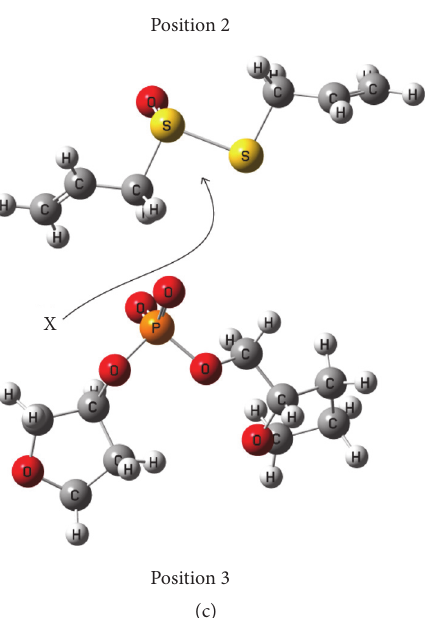
Figure 2: Investigated complex structures: allicin cases with G-C base pair (a), A-T base pair (b), and bridge of base pairs (c) after optimizations. X shows the initial position before optimization. Positions 1, 2, and 3 represent the pattern of artificial made initial model structures and its complexes. Similar complexes modeled with all interacting